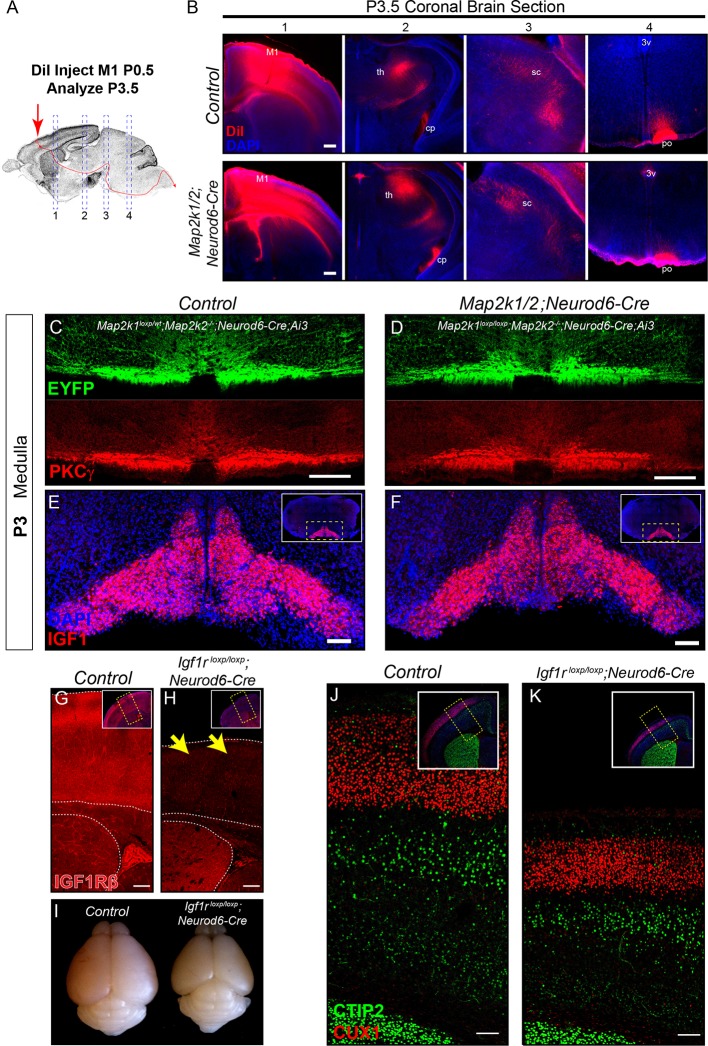
The rostrocaudal elongation of layer 5 axons in the spinal cord requires ERK/MAPK, but not IGF1R, signaling.(A–B) In vivo DiI injections into the sensorimotor cortex were performed in P0.5 control and Map2k1/2;Neurod6-Cre neonates to label subcortical projection neuron afferents (A). Mice were collected three days after injection and the extent of DiI labeling in multiple subcortical targets was analyzed in coronal sections through the brain (B). A substantial difference in the innervation of the thalamus (th), cerebral peduncle (cp), superior colliculus (sc), or pons (po) was not detected in mutants (B) (n=3, scale bar=100 µm). C-D. Cross sections through the medulla were labeled with EYFP and PKCγ in P3 control (C) and Map2k1/2;Neurod6-Cre;Ai3 mutant (D) hindbrains. No overt change in CST size was detected in mutant mice, providing evidence that cortical layer 5 axon outgrowth to the hindbrain does not require ERK/MAPK signaling (n=3, scale bar=100 µm). (E–F) At P3, IGF1 expression is high in the inferior olive adjacent to the location of the developing CST in control neonates (E). Map2k1/2;Neurod6-Cre mutants did not exhibit a qualitative difference in IGF1 expression (F) (n=3, scale bar=100 µm). (G–K) A substantial loss of IGF1Rβ protein expression (yellow arrows) was observed in the developing cortex of Igf1rloxp/loxp;Neurod6-Cre mutant mice (H) when compared to controls (G) (scale bar=200 µm). The loss of IGF1R signaling led to a relatively reduced brain size when compared to P7 littermates (I), but had no effect on the expression of CTIP2 or CUX1 in the sensorimotor cortex of Igf1rloxp/loxp;Neurod6-Cre mutants (K) relative to controls (J) (n=3) (scale bar=100 µm).